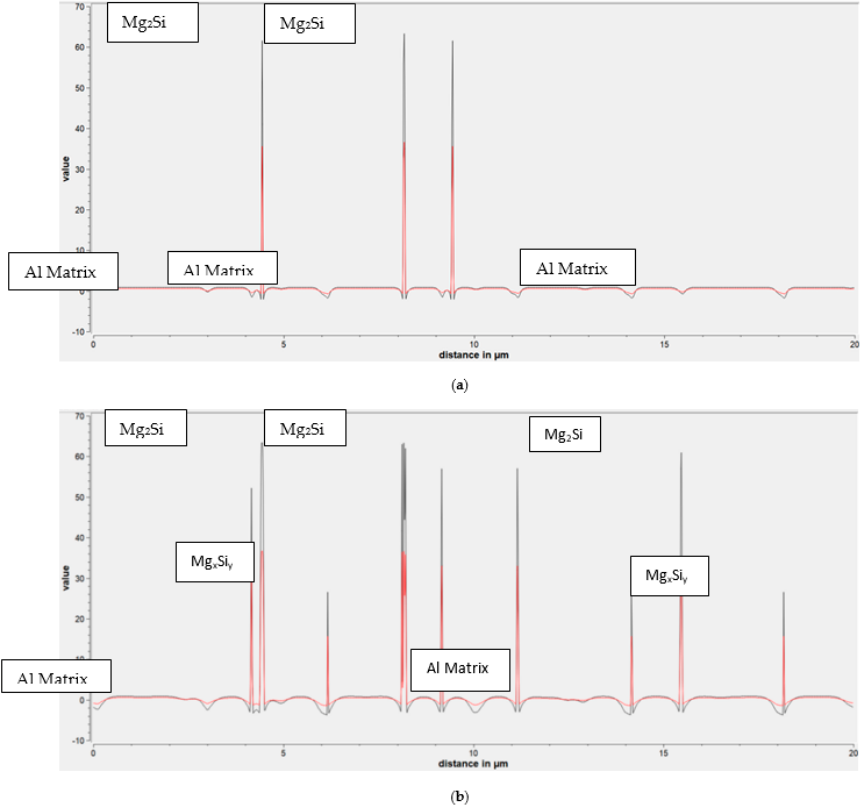
Figure 15. Virtual EDX analysis for the ternary Al-0.9Mg-0.6Si system for: 180 ( a ) and 200 ◦ C ( b ). The horizontal axis depicts the position in the central line of the microstructure, while the vertical axis depicts the corresponding wt.% composition in Mg (black curve) and Si (red curve). The white boxes represent the corresponding phase for each couple of Mg-Si concentrations.